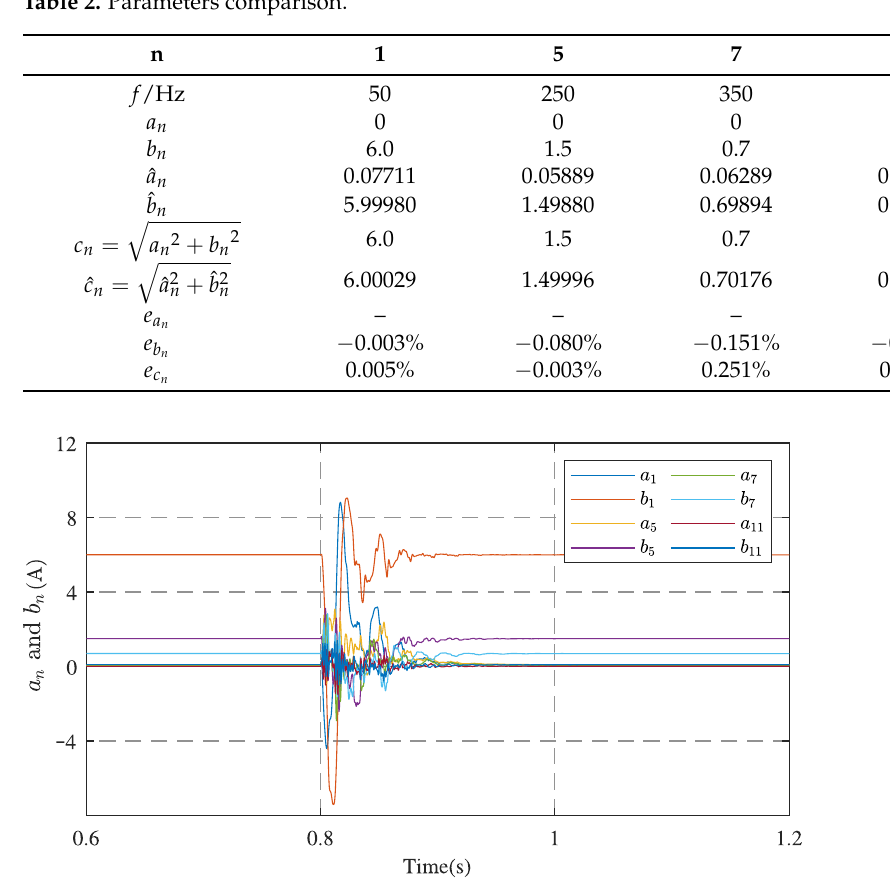
Figure 12. The values of each harmonic parameter extraction with phase jump.